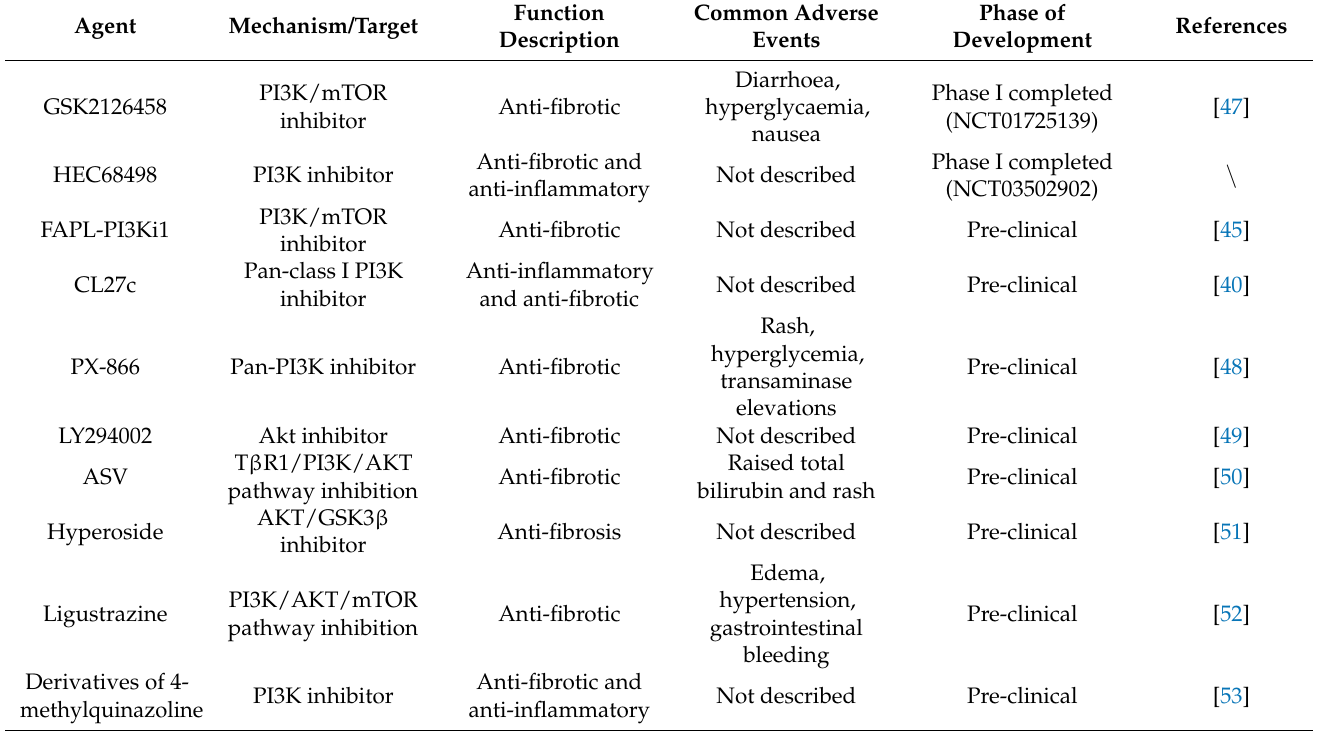
Table 2. PI3K pathway inhibitors of pulmonary